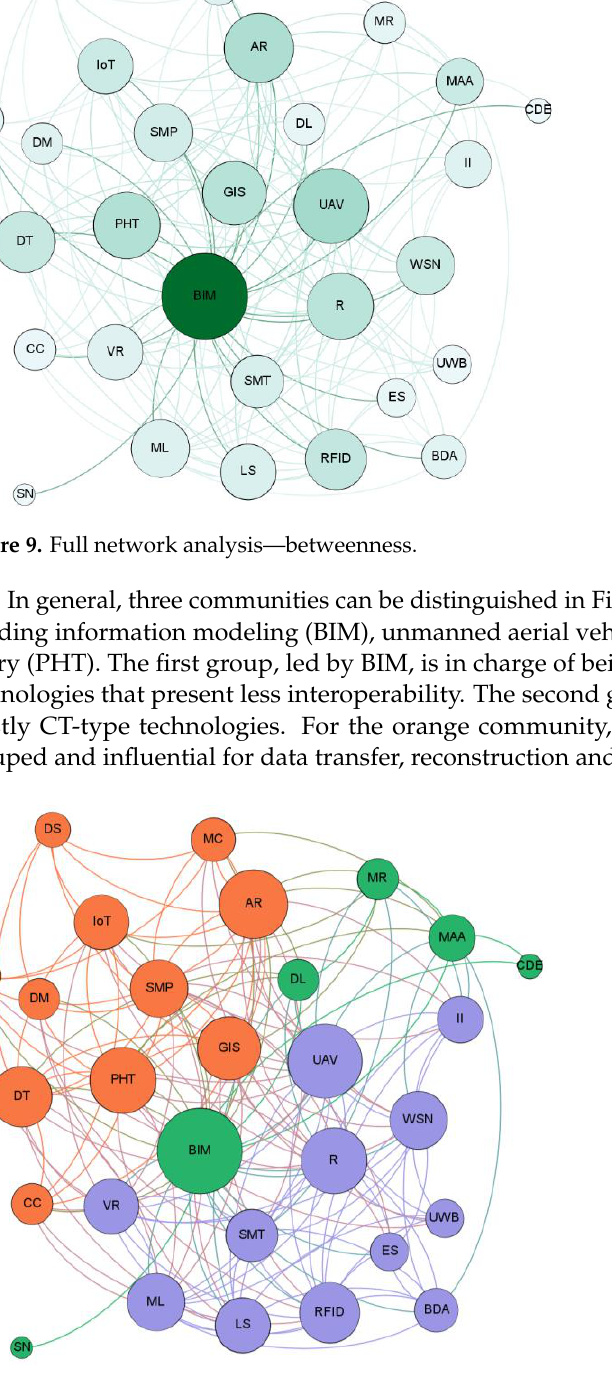
Figure 10. Full network analysis—modularity.